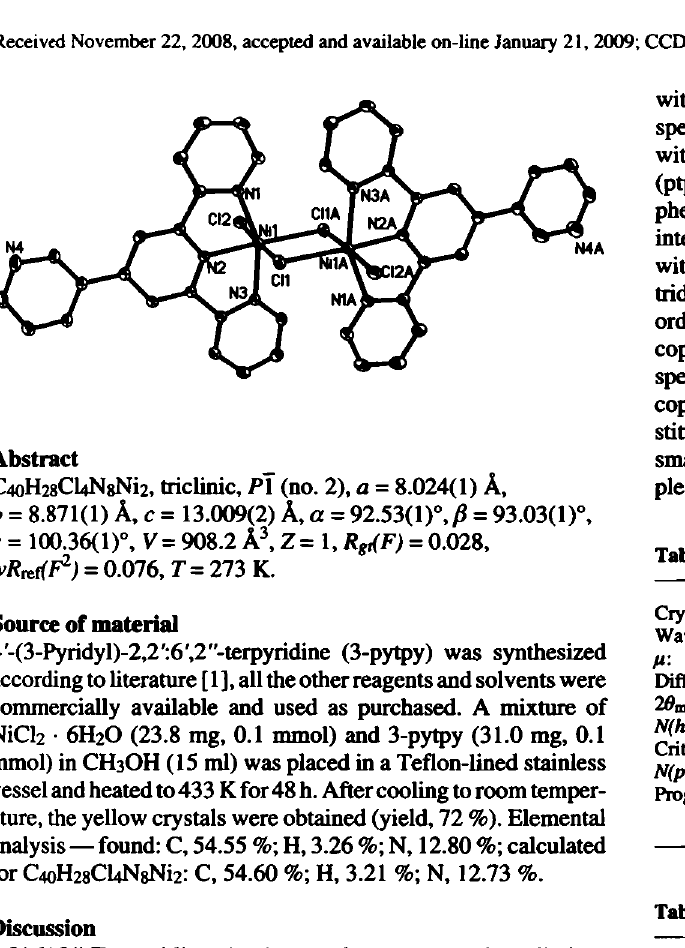
Table 2. Atomic coordinates and displacement parameters (in Â 2